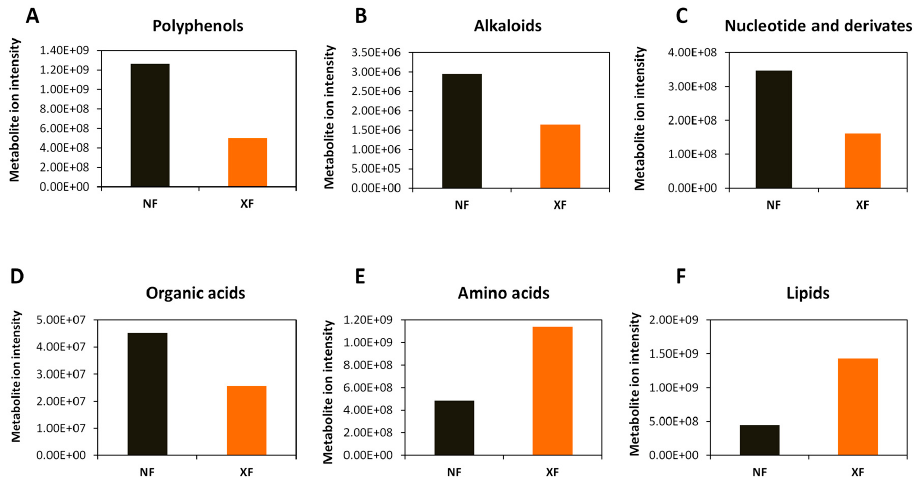
Figure 6. Comparison of the total ion intensity of various classes of metabolites between fruits from Ningxia (NF) and Xinjiang (XF). ( A ) Polyphenols, ( B ) alkaloids, ( C ) nucleotides and derivatives, ( D ) organic acids, ( E ) amino acids and ( F ) lipids. Bars represent the sum of ion intensity of all metabolites belonging to each class.